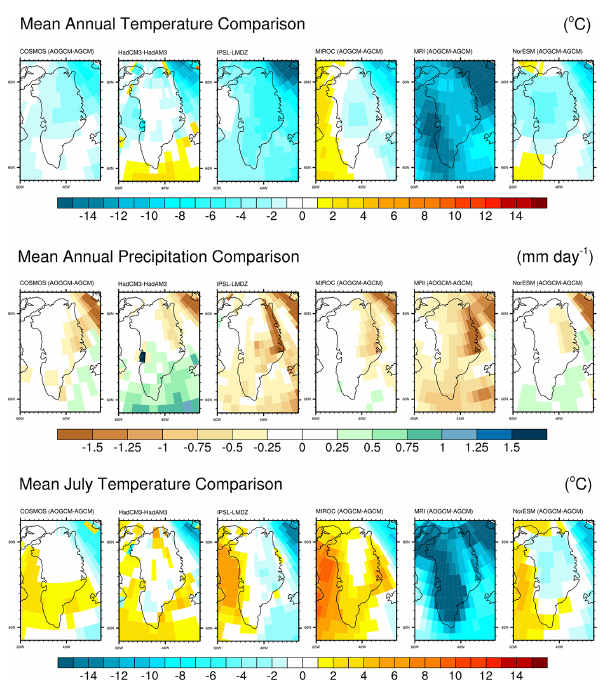
Figure 12. mPWP mean annual temperature ( ◦ C) and precipita- tion (mm day − 1 ) , and mean July temperature differences simulated between the AOGCMs and AGCMs over Greenland for compara- ble models from the PlioMIP ensemble (AOGCM climate minus AGCM